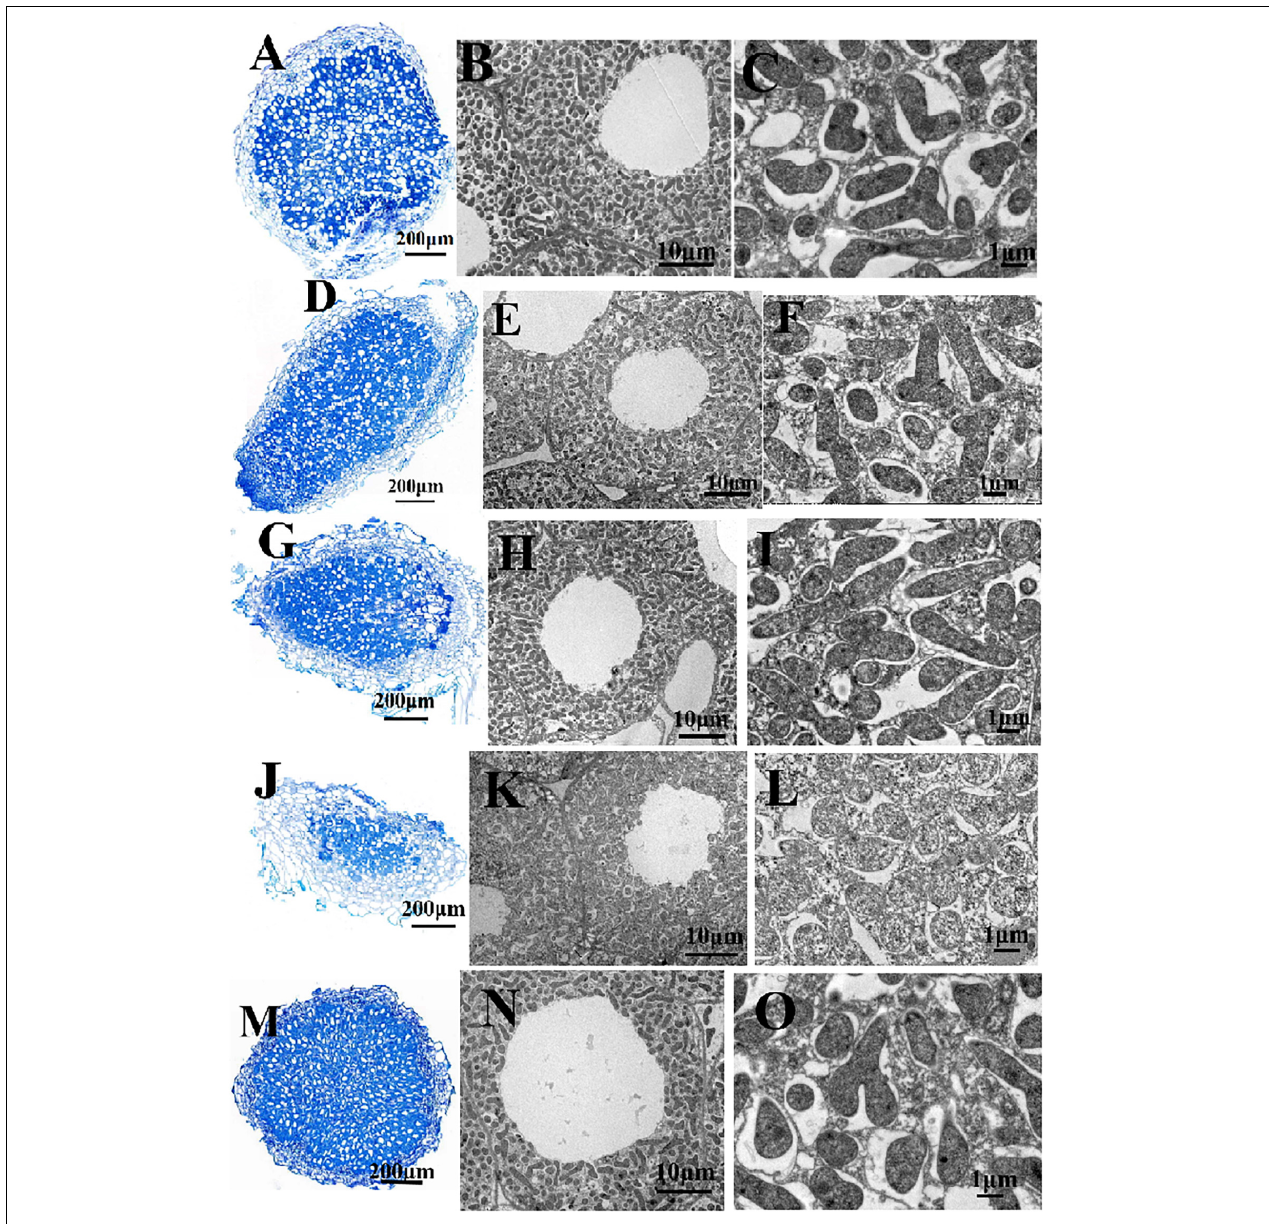
FIGURE 3 | Structure of pea nodules and bacteroids. Root nodules were induced by RL3841 (A–C) , RLgshR (D–F) , RLgpxA (G–I) , RLgshRgpxA (J–L) , RLgpxA(pBBRgpxA) (M–O) . Scale bars = 200 µ m (A,D,G,J,M) , 10 µ m (B,E,H,K,N) , 1 µ m (C,F,I,L,O)